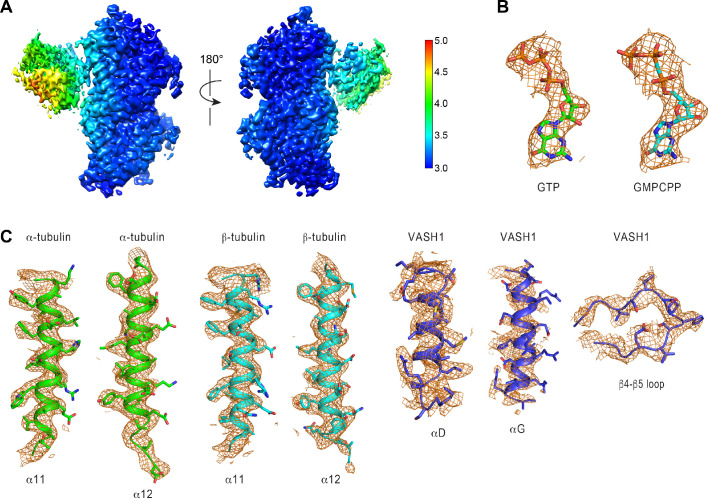
Cryo-EM map of VASH1-SVBP-decorated GMPCPP-microtubules.(A) Density corresponding to the αβ-tubulin heterodimer and the VASH1-SVBP complex colored by local resolution as determined in relion_postprocess. (B) Electron density map of nucleotides in the N-site (left) and E-site (right) of microtubules. (C) Representative regions of the cryo-EM map of α-tubulin, β-tubulin, and VASH1, highlighting the density of key residues at VASH1-microtubule interfaces.